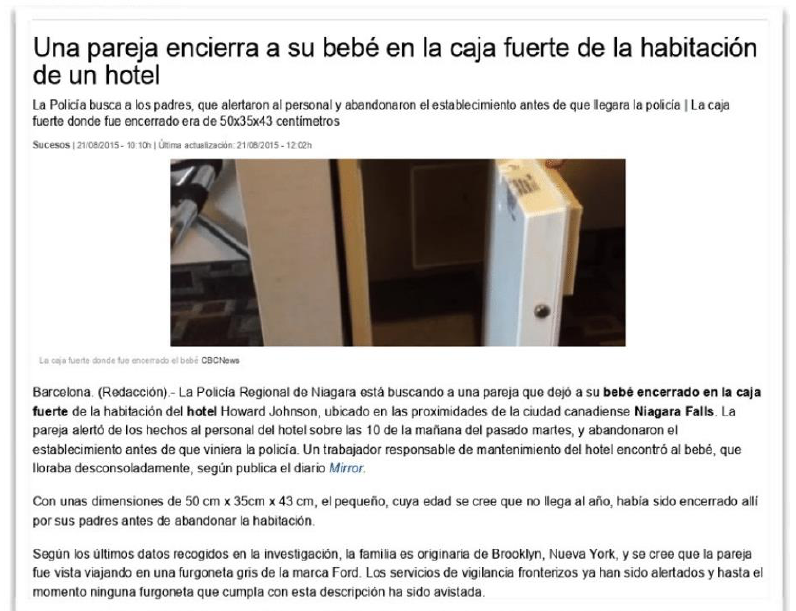
Figure 3. A couple locks their toddler in the safe of their hotel’s room. Piece of news presented in the activity 2.